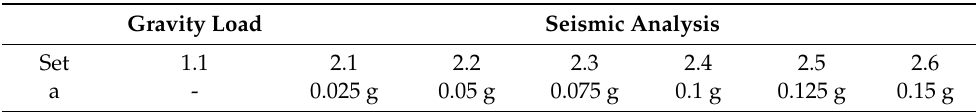
Table 7. Acceleration values associated with the different analysis sets.